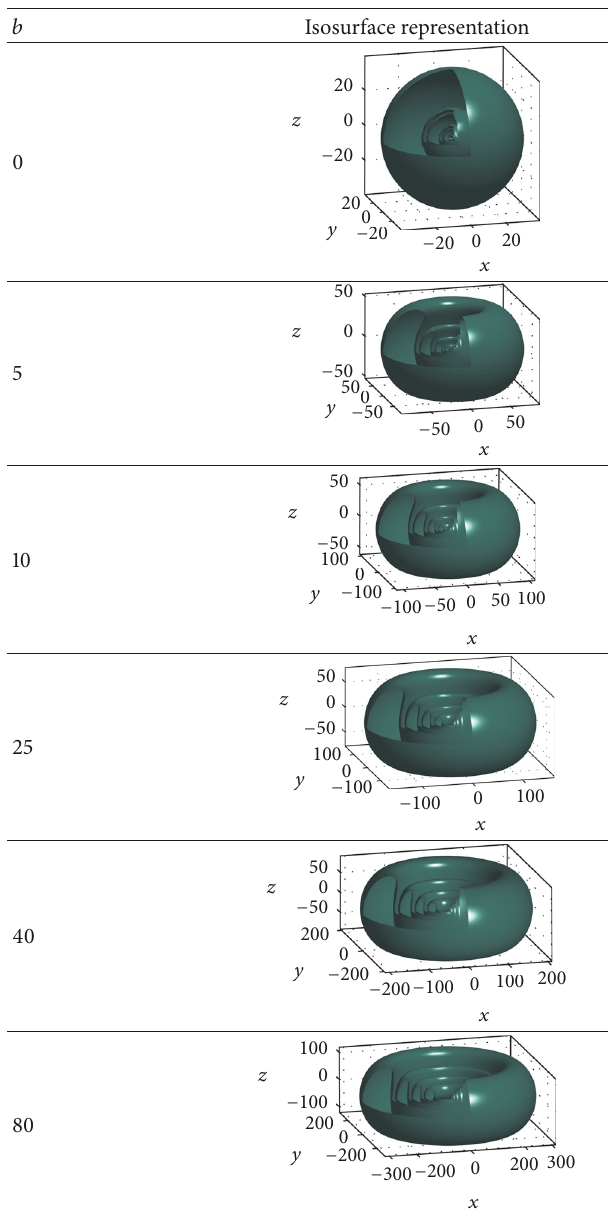
Table 5: Three-dimensional isosurface representation of (4,0, 0) for different positive values 𝑏 .